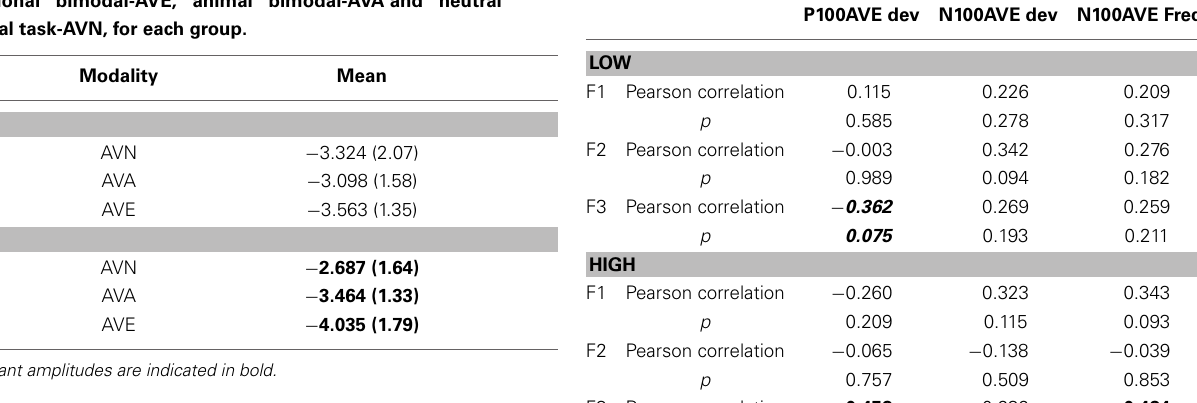
Table 8 | Pearson correlations an R 2 between the 3 sub-scores on the